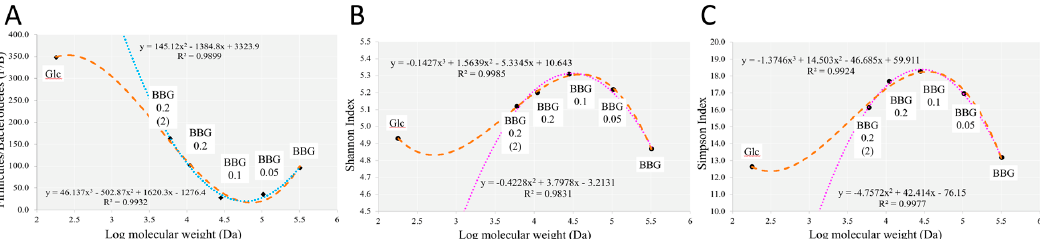
Figure 10. Correlation analysis of selected parameters against BBGs of different MWs with glucose as monomer. ( A ) Firmicutes/Bacteroidetes ratio; ( B ) Shannon α -diversity; ( C ) Simpson α -diversity.